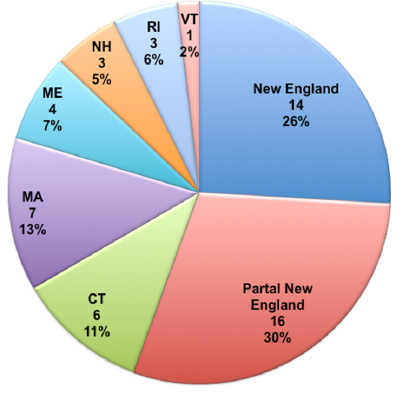
Figure 4. Study areas of the 54 cases.